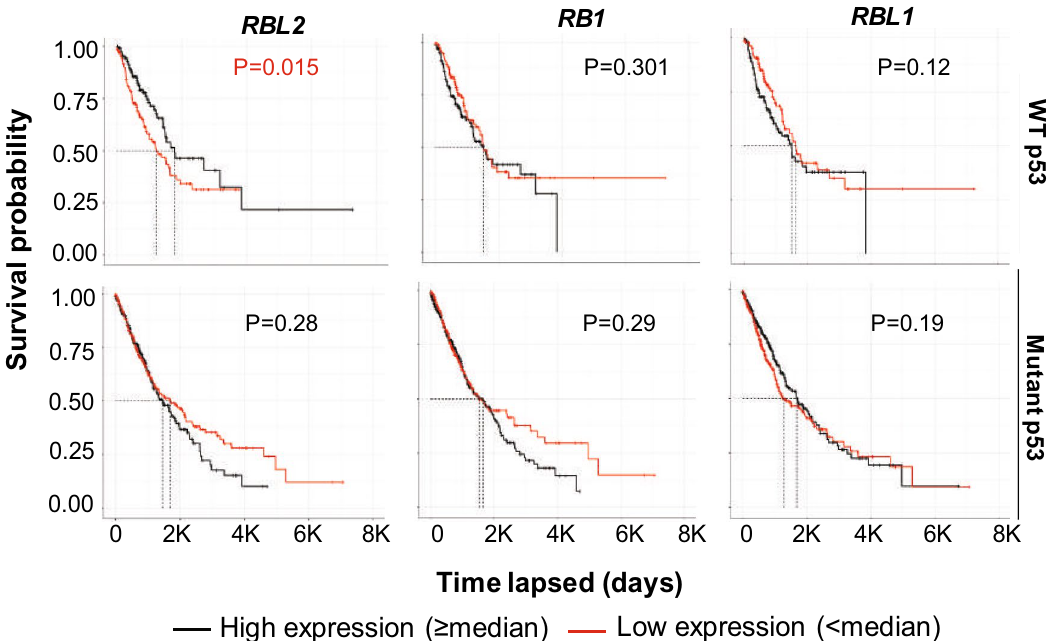
Figure 1. High expression of RBL2 correlates with better prognosis in NSCLC. Expression of DREAM-complex genes are tested for correlation with survival in all 994 NSCLC patients in TCGA. High expression (≥ median) of RBL2 significantly (p = 0.015) associates with better survival in WT p53 patients but not (p = 0.28) mutant p53 patients. Other DREAM component genes and RB1/RBL1 do not significantly associate with prognosis (p values